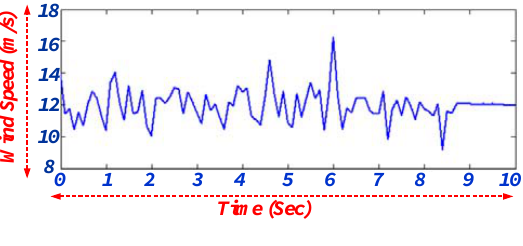
Figure 9. Wind speed input pattern.